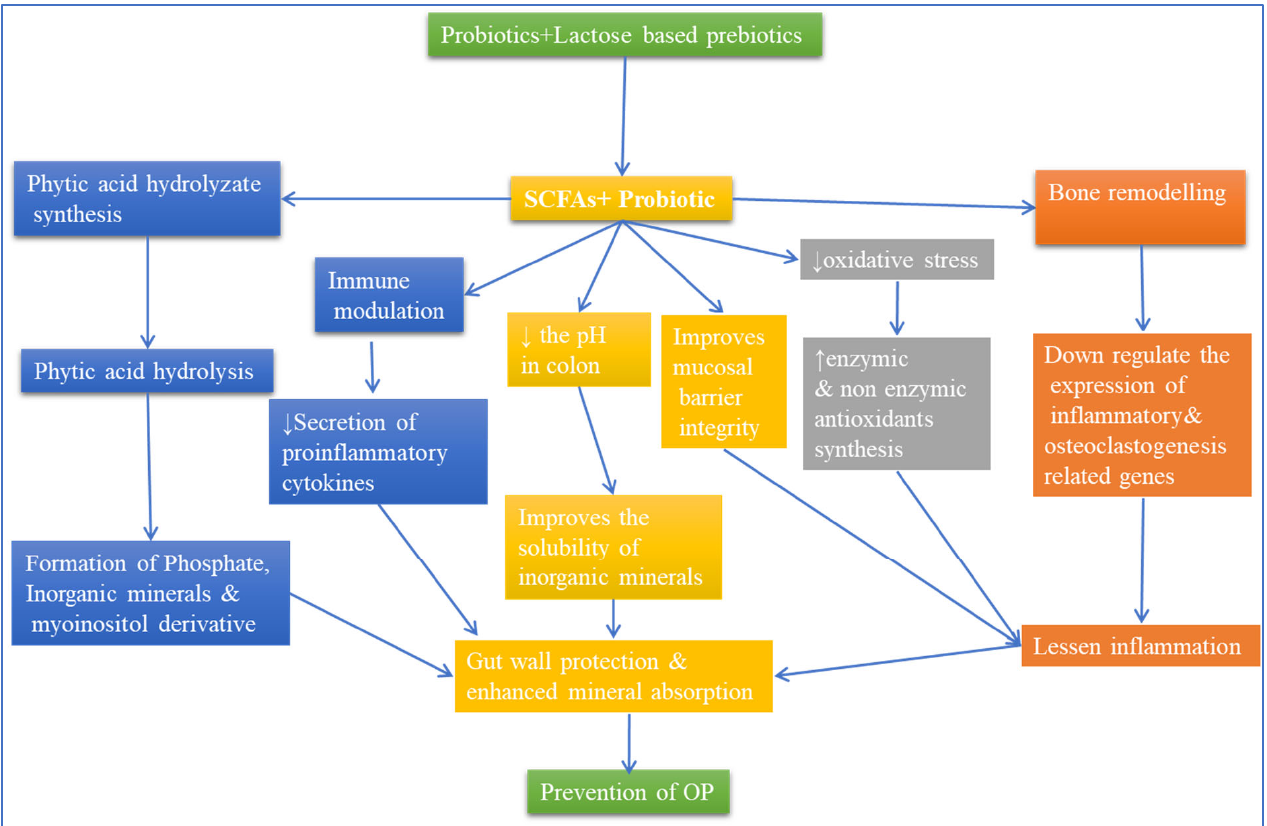
Figure 3. Effect of microbiota on osteoporosis and the crucial regulatory factors in bone metabolism. Beneficial microbes of the gut are influenced by diet, antibiotics, and probiotics. This impact has down- stream ramifications, especially on bone mass, via multiple mechanisms. For instance, microbiota abundance does impact estrogen bioavailability which is crucial in bone mass. Secondly, microbiota does support the immune system by modulating the expression of inflammatory cytokines. Thirdly, gut microbiota can generate metabolites such as short-chain fatty acids. It has also been shown that gut microbiota does alter intestinal permeability and enhances vitamin D availability and bone mineral absorption. Finally, the gut microbiome is known to affect the gut-brain axis via the modulation of the abundance of hormones: 5-HT- 5-hydroxytryptamine; IGF-insulin-like growth factor, SCFA, short-chain fatty acid, PTH-Parathyroid